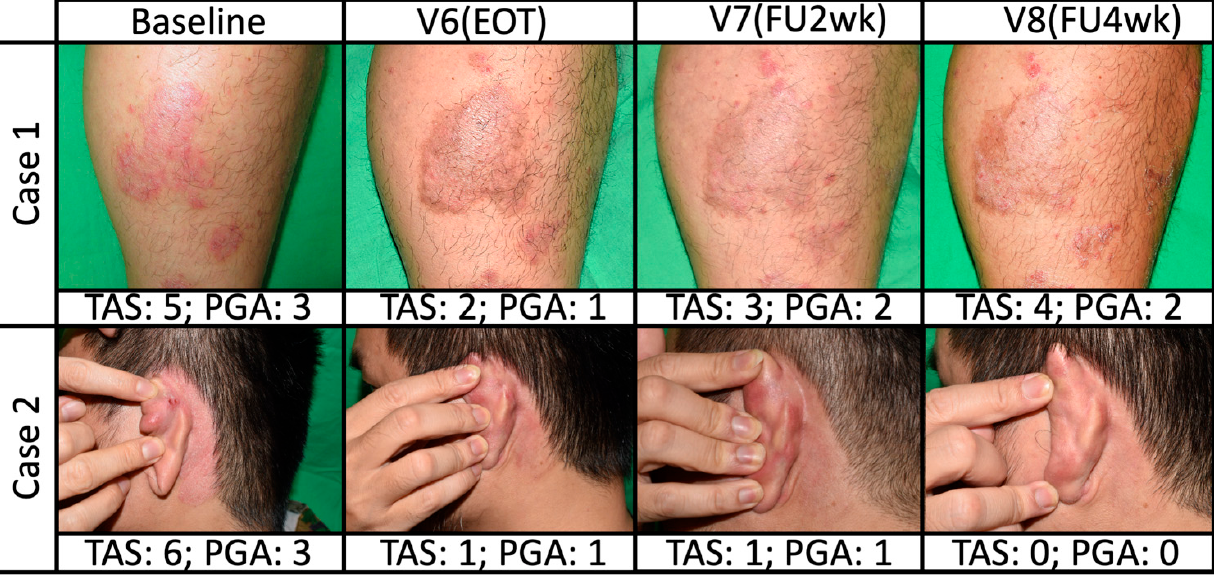
Figure 3. Representative photographs of two participants treated with topical KX01 at stage IV.